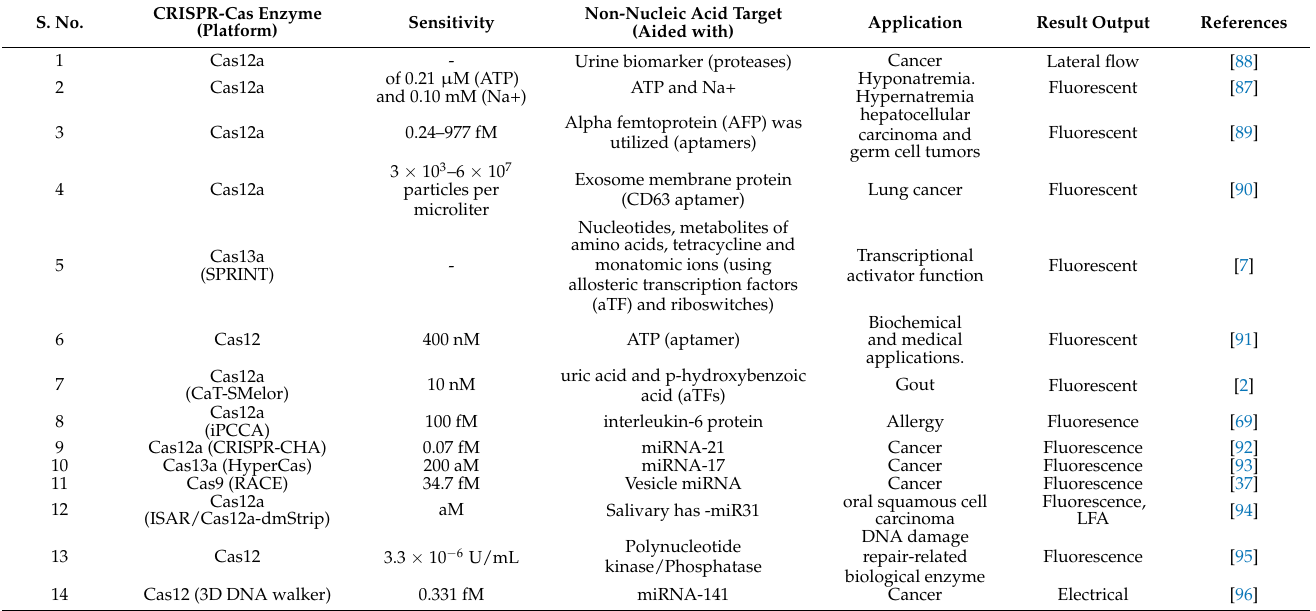
Table 2. List of CRISPR/Cas based non-nucleic acid detection platforms developed for diagnostics